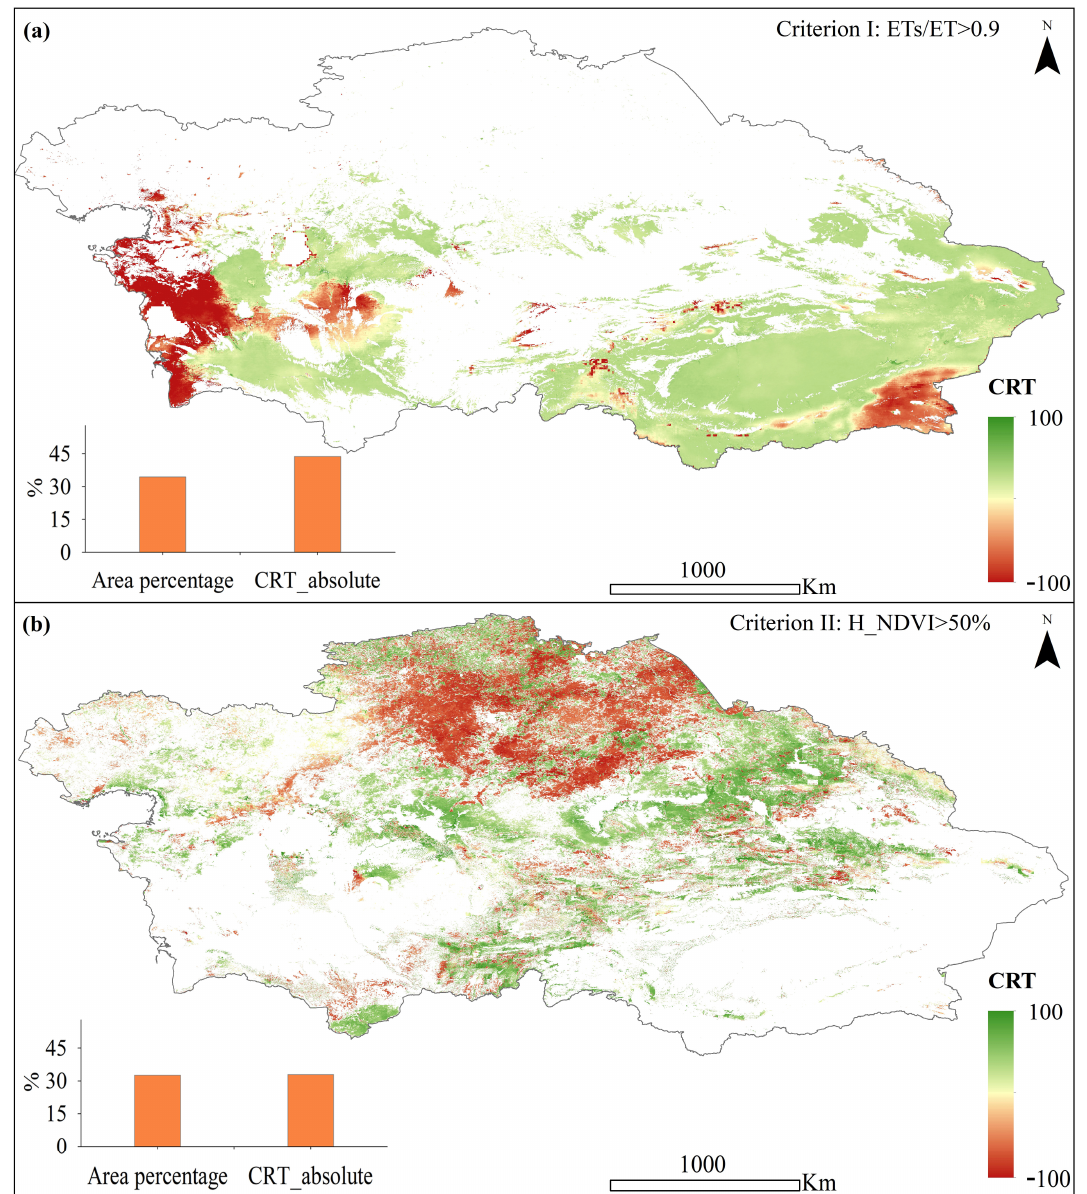
Figure 6. Contribution rate of human activities to ET , distinct from the contribution rate of VH coupling factors to ET . ( a ) Contribution rate of human activities to ET in areas with no or extremely weak vegetation; ( b ) Contribution rate of human activities to ET in other areas where human activities dominate the NDVI. The histogram in panels ( a , b ) shows the area percentages where human activity dominates ET change and the average absolute contribution rate of human activity to ET in the area where human activity dominates the contribution rate of the VH coupling factor to ET .